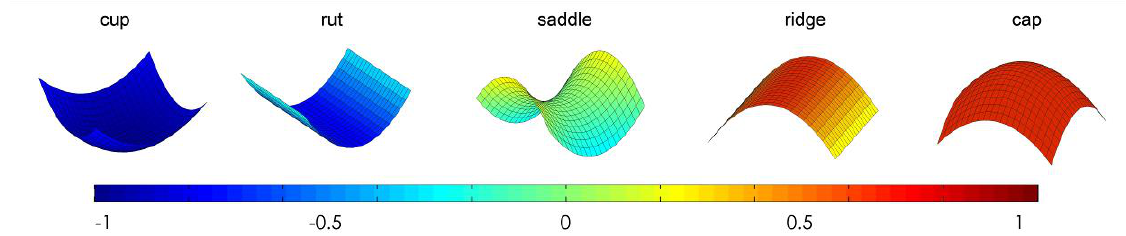
Figure 2: The surface morphology in the range of Shape Index.